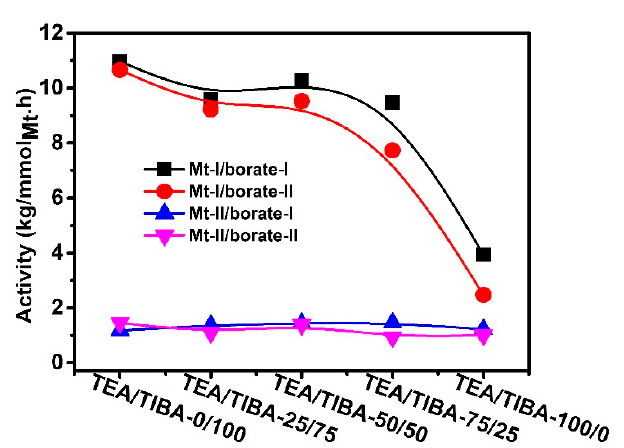
Figure 7. Effects of alkylaluminum on activity of propylene